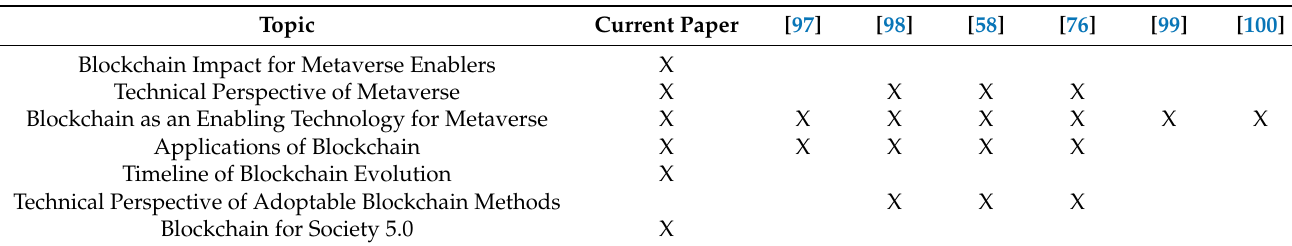
Table 4. Comparison of the contribution of this paper with the pertinent